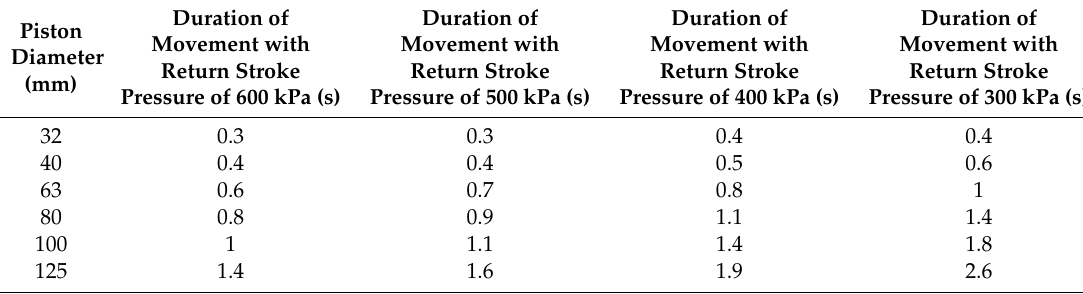
Table 4. The duration of cylinder piston movement in the return